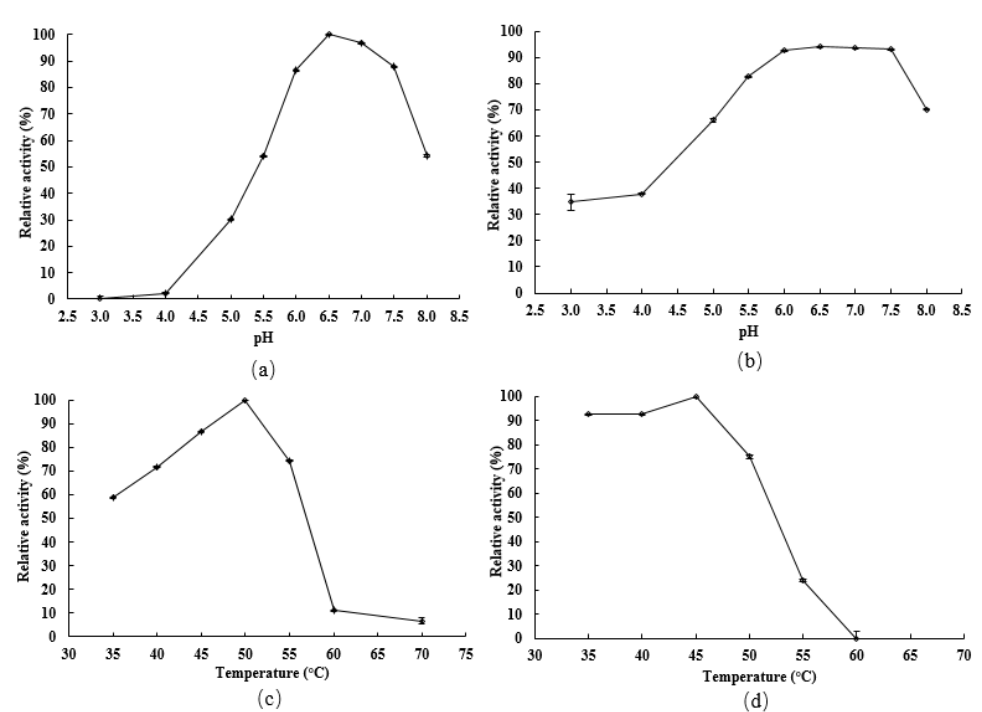
Figure 3. pH and temperature pro fi les of LcFFase1s. E ff ect of pH on the activity ( a ) and stability ( b ) was performed at 40 °C in 50 mM sodium hydrogen phosphate–citrate bu ff er. The remaining activities were measured after incubation for 30 min at 40 °C over various pH ranges. E ff ect of temperature on the activity ( c ) and thermostability ( d ) of LcFFase1s was determined at temperatures ranging